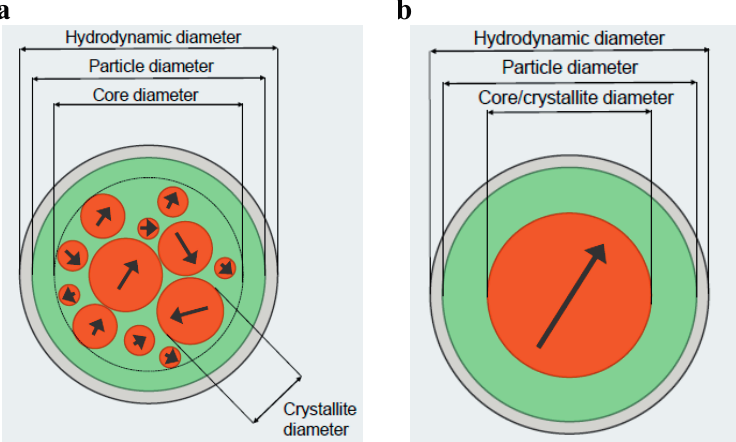
Figure 3. Schematic pictures of magnetic ( a ) multi-core particles and ( b ) single-core particles. The definitions of the size parameters of the two different particle types are also shown in the figure. See the text for an explanation of the